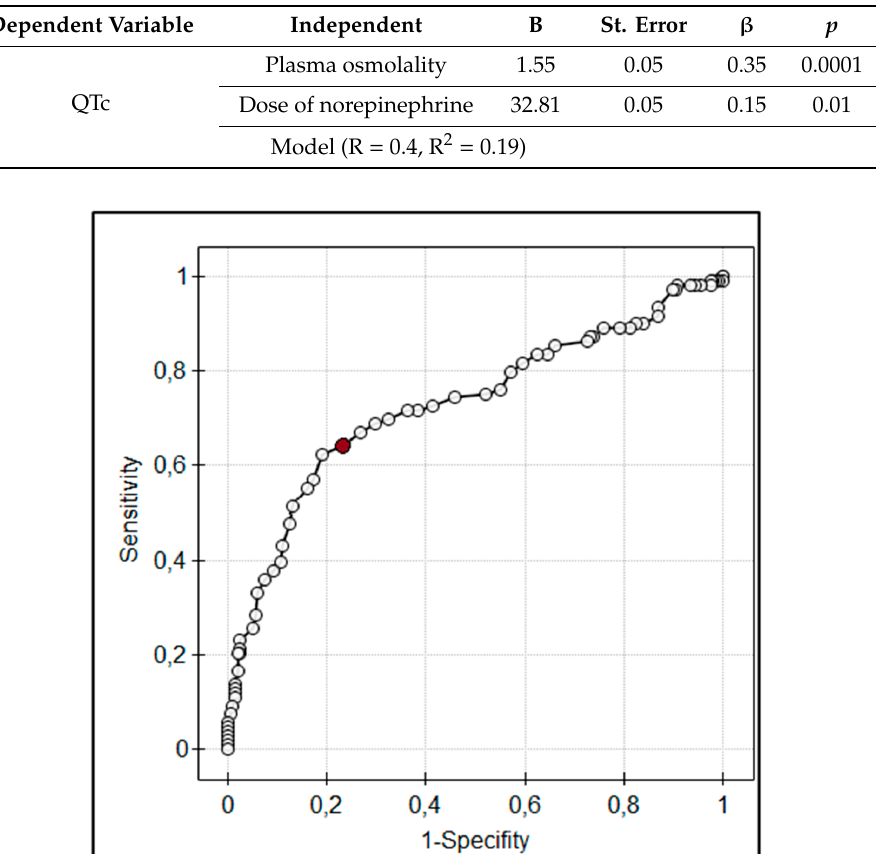
Figure 3. The receiver-operator characteristics (ROC) curve for corrected QT interval (QTc) and plasma osmolality in the study population. Increase in plasma osmolality above 313 mOsm/kg H 2 O increases the risk for QTc prolongation >500 ms.